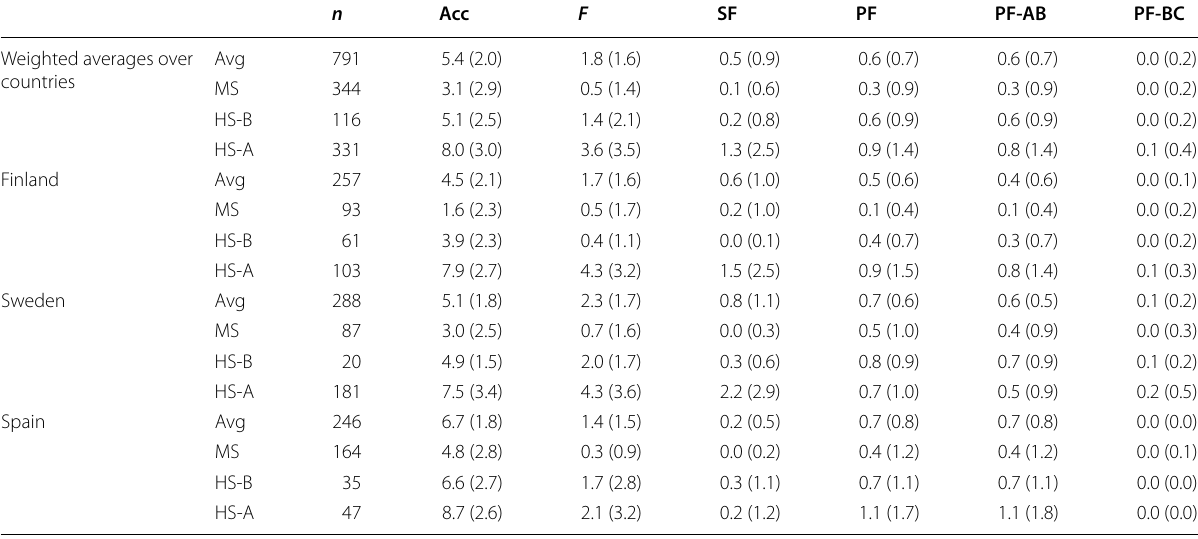
Table 2 Summary of key variables (mean and standard deviation) related to flexibility, for all students in Finland, Sweden and Spain